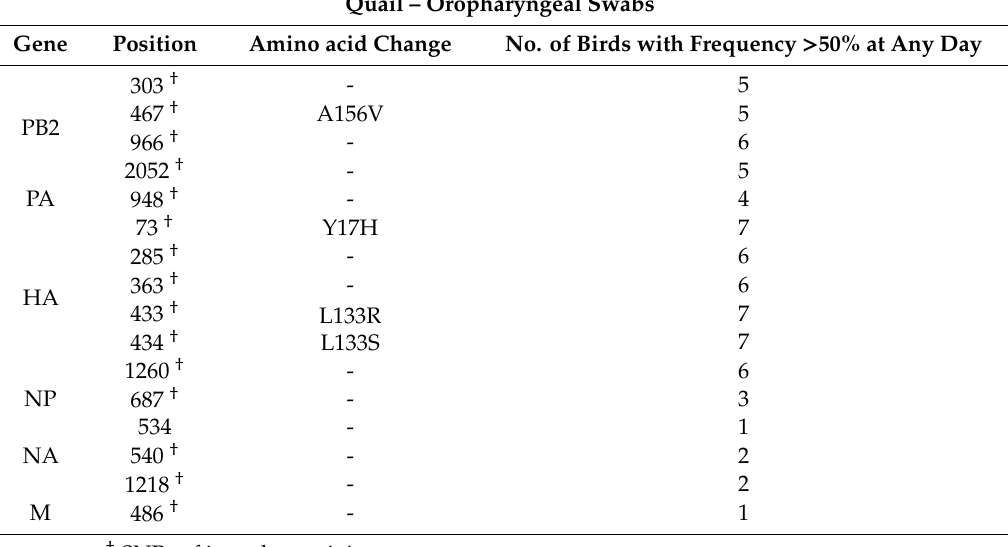
Changes in the consensus sequences in samples collected from quail infected with A / turkey / Poland / 14 /